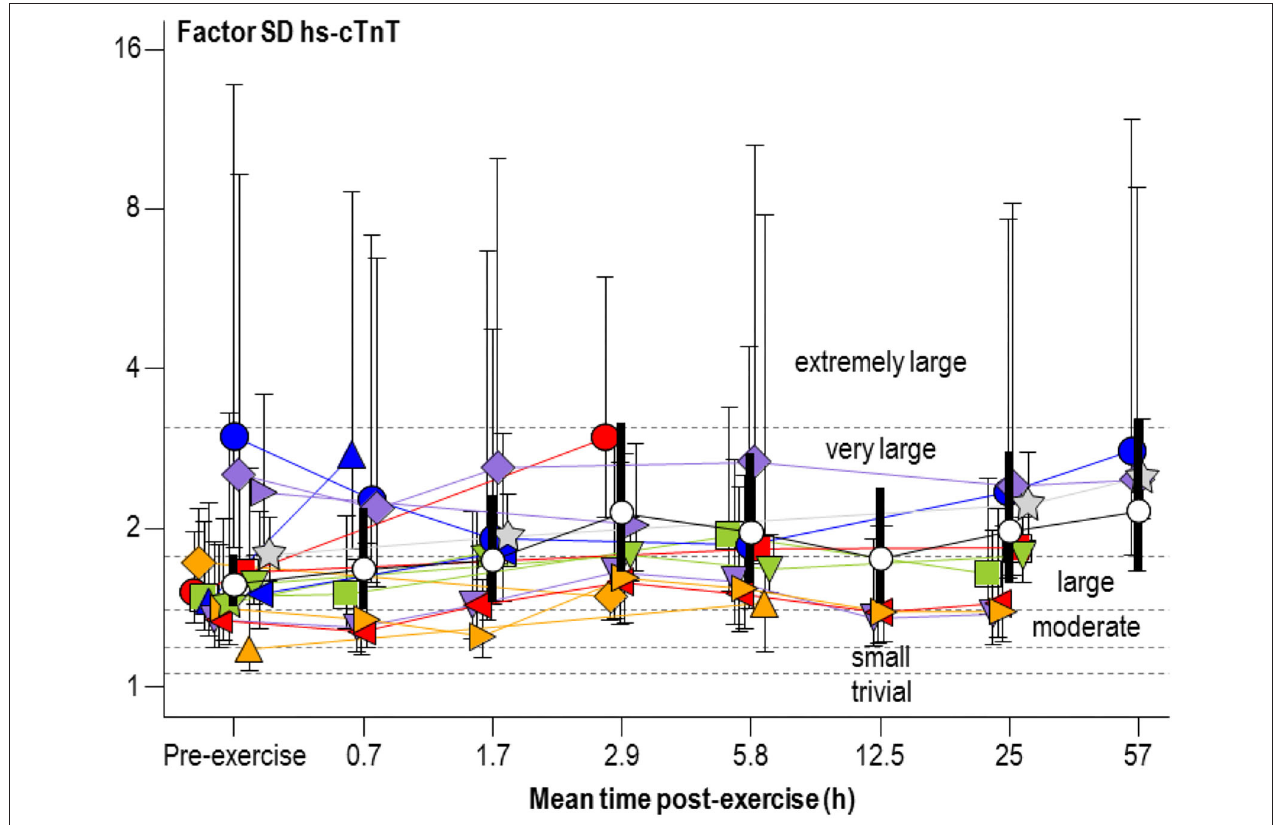
FIGURE 3 | Individual study-estimate and meta-analyzed predicted factor standard deviations (SD) of serum concentration of high-sensitivity cardiac troponin T (hs-cTnT) for athletes and exercise shown in Figure 2 Bars are 90% compatibility